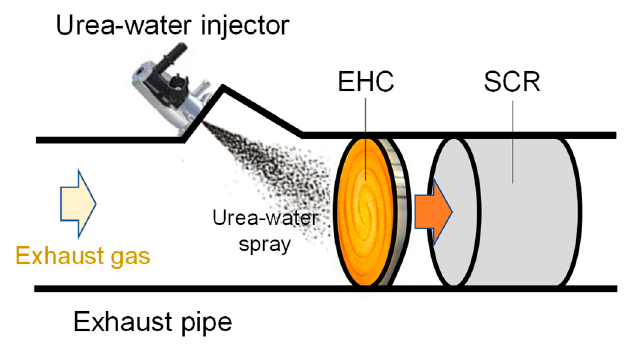
Figure 1. Illustration of EHC-based diesel urea-SCR system.